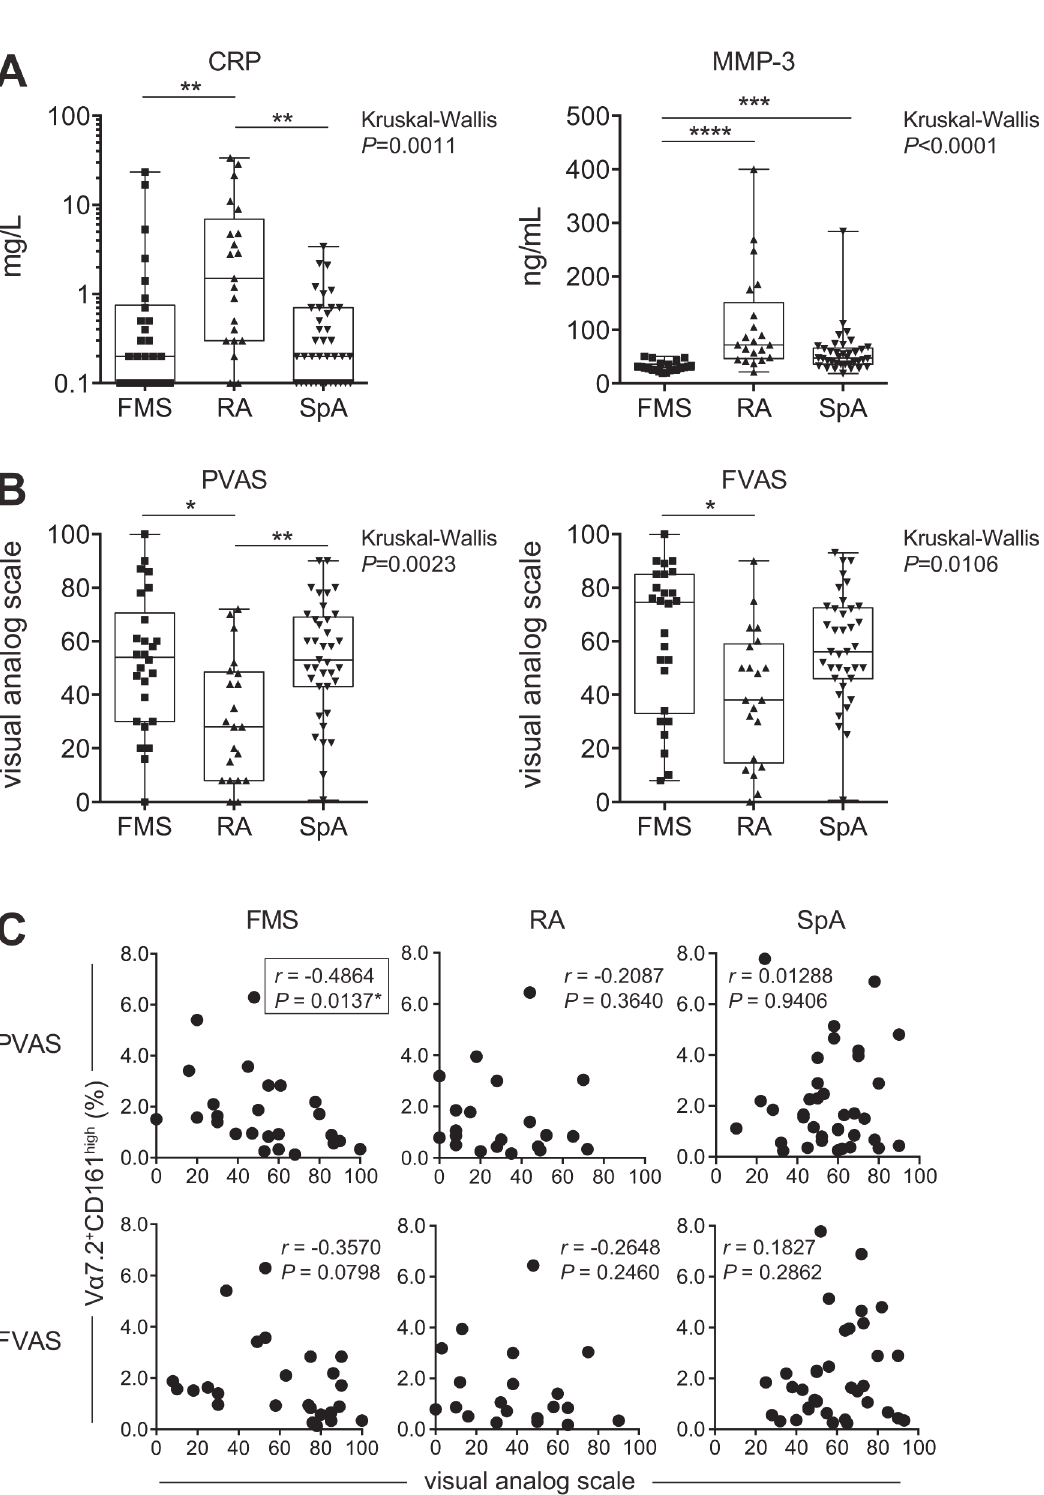
Fig 4. Biochemical and physical parameters in FMS, RA, and SpA. A: Serum CRP concentrations in FMS, RA, and SpA (left panel).: Serum MMP-3 concentrations in FMS, RA, and SpA (right panel). B: PVAS in FMS, RA, and SpA (left panel).: FVAS in FMS, RA, and SpA (right panel). A-B. Horizontal line: Median; boxes: 25th percentile and 75th percentile; whiskers: Minimum and Maximum. Asterisk shows the group-pairs exhibiting significance. * : P < 0.05, ** : P < 0.01, *** : P < 0.001 ( P value adjusted after the Kruskal-Wallis test with the Dunn's multicomponent test). C: Correlation between PVAS/FVAS and MAIT cell percentage (% of V α 7.2 + CD161 high cells among CD3 + cells) in a cohort of 26 FMS (left panels), of 21 RA (middle panels), and of 36 SpA (right panels) patients. The correlation was analyzed with the Spearman rank correlation test. * : P < 0.05, r: correlation coefficient.